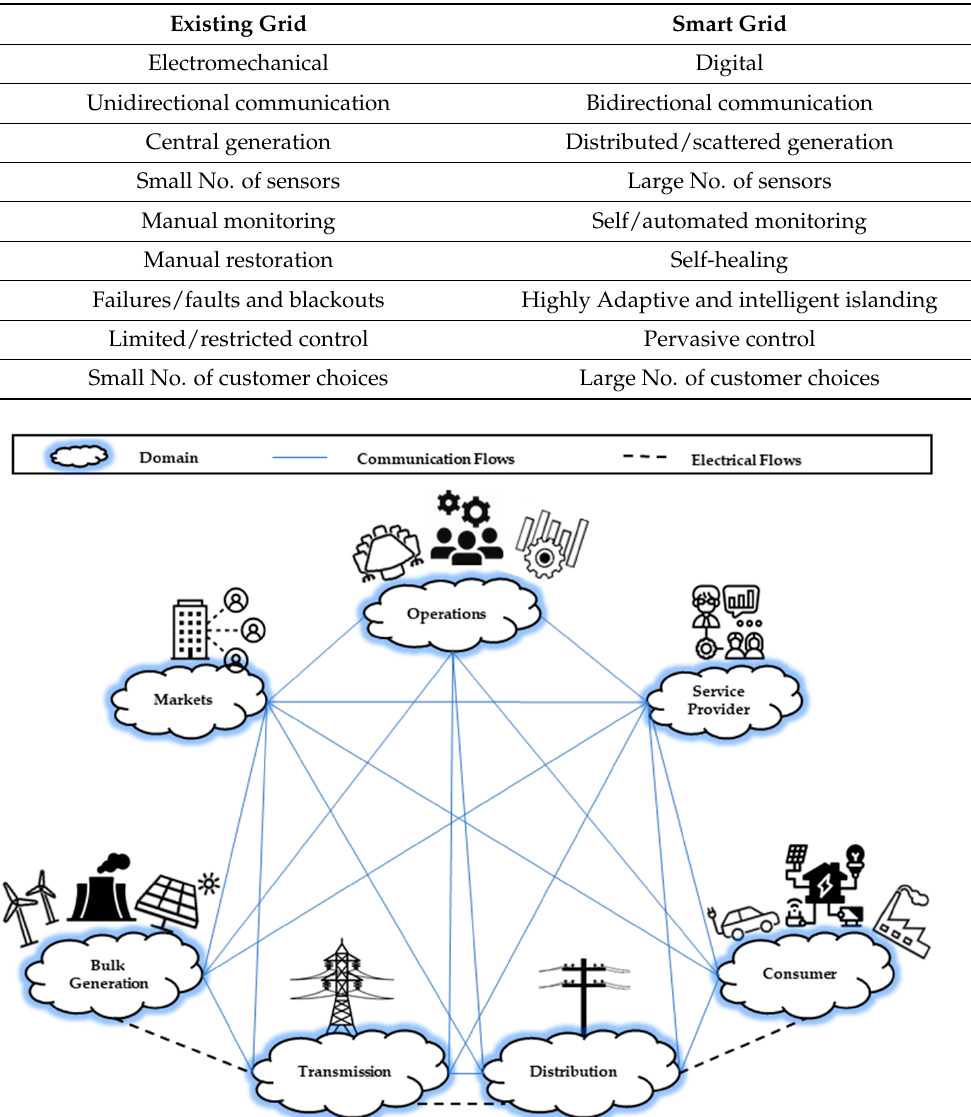
Table 2. Domains and actors in the NIST SG model